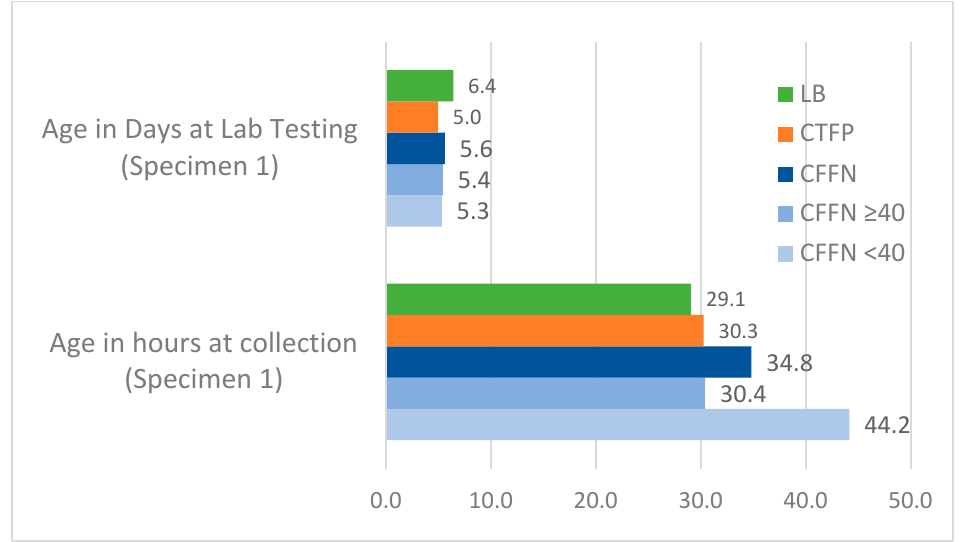
Figure 4. Weighted average median age at specimen collection and laboratory testing for all study groups in 6 one-specimen states.